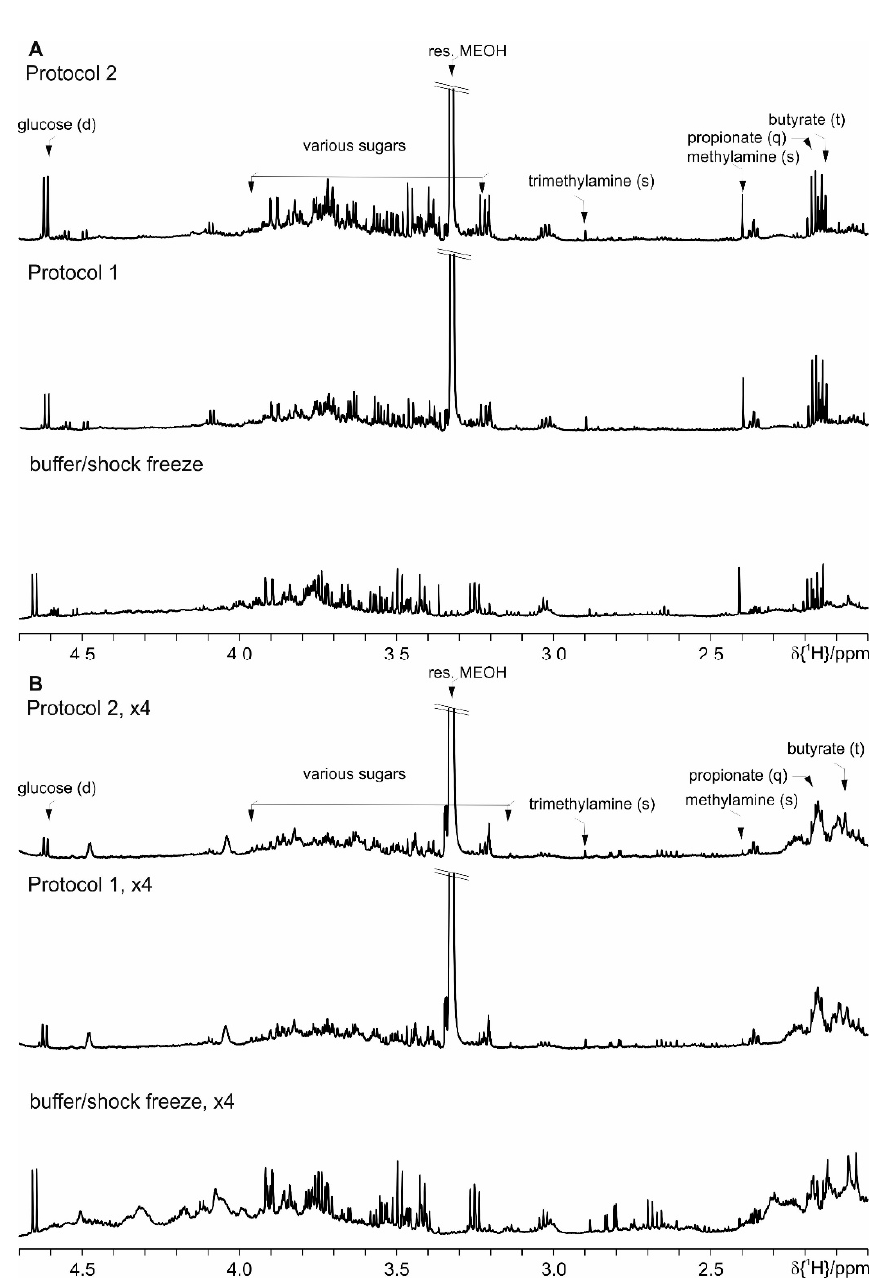
Figure 10. Comparison of Protocol 1 and 2 with the basic protocol with shock freeze: ( A ) feces of mice fed on a standard diet and ( B ) on HFD (the intensity is upscaled four times). For clarity only a selected spectral range (2.0 ppm till 4.7 ppm) of the proton NMR spectra is shown, where the most prominent metabolites are marked.